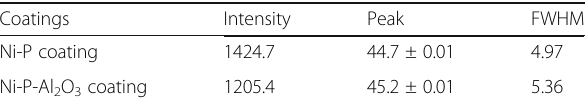
Table 1 The characteristic parameters of diffraction peak of Ni-P (111) in the Ni-P coating and Ni-P-Al 2 O 3 (3.6 wt%) coatings Coatings